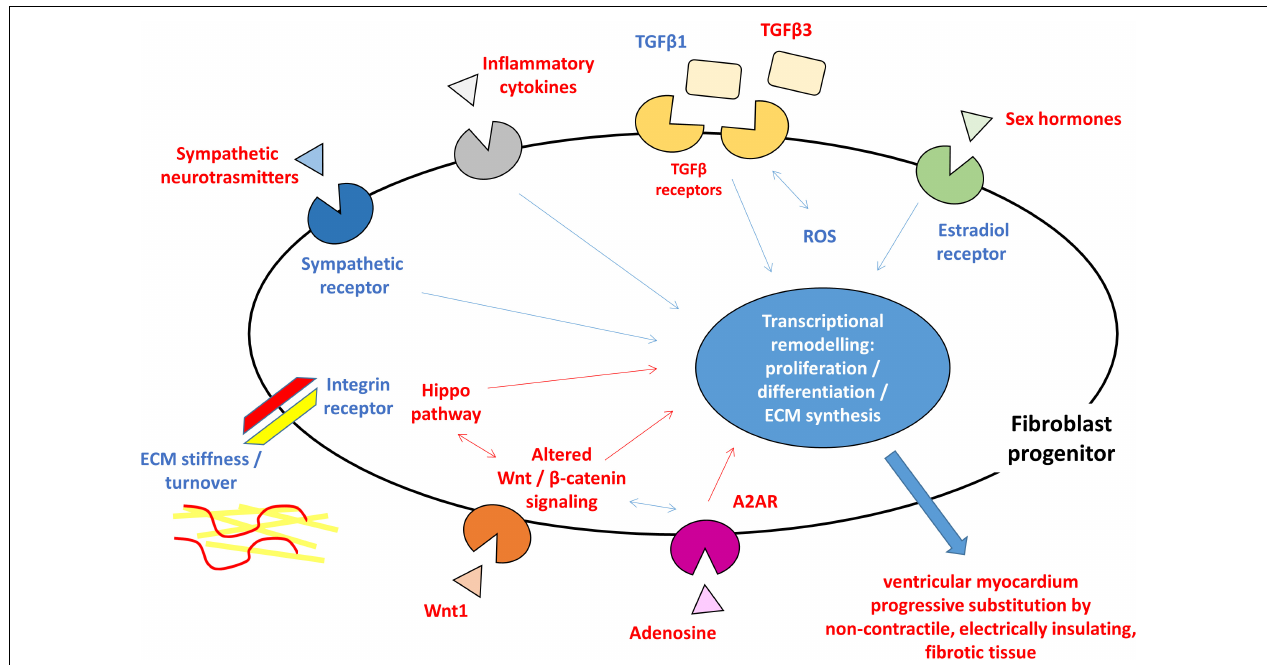
FIGURE 1 | Schematic figure highlighting the hypothesized pro-fibrotic process in ACM. The presence of different triggers (sympathetic nervous system activity, extracellular matrix ECM component, reactive oxygen species ROS, inflammatory cytokines, and sex hormones) and the activation of molecular pathways (Hippo, Wnt/ β -catenin, and TGF β ) lead to transcriptional rearrangement for excessive proliferation and myofibroblasts differentiation of fibroblast progenitors. These changes ultimately result in ventricular myocardium progressive substitution by non-contractile, electrically insulating, fibrotic tissue. In blue, what is known about pro-fibrotic mechanisms in general and hypothesized in ACM, in red what is reported for ACM pathogenesis. ACM: arrhythmogenic cardiomyopathy; A2AR: adenosine 2A receptor; ECM: extracellular matrix; ROS: reactive oxygen species; TGF β : transforming growth factor β .